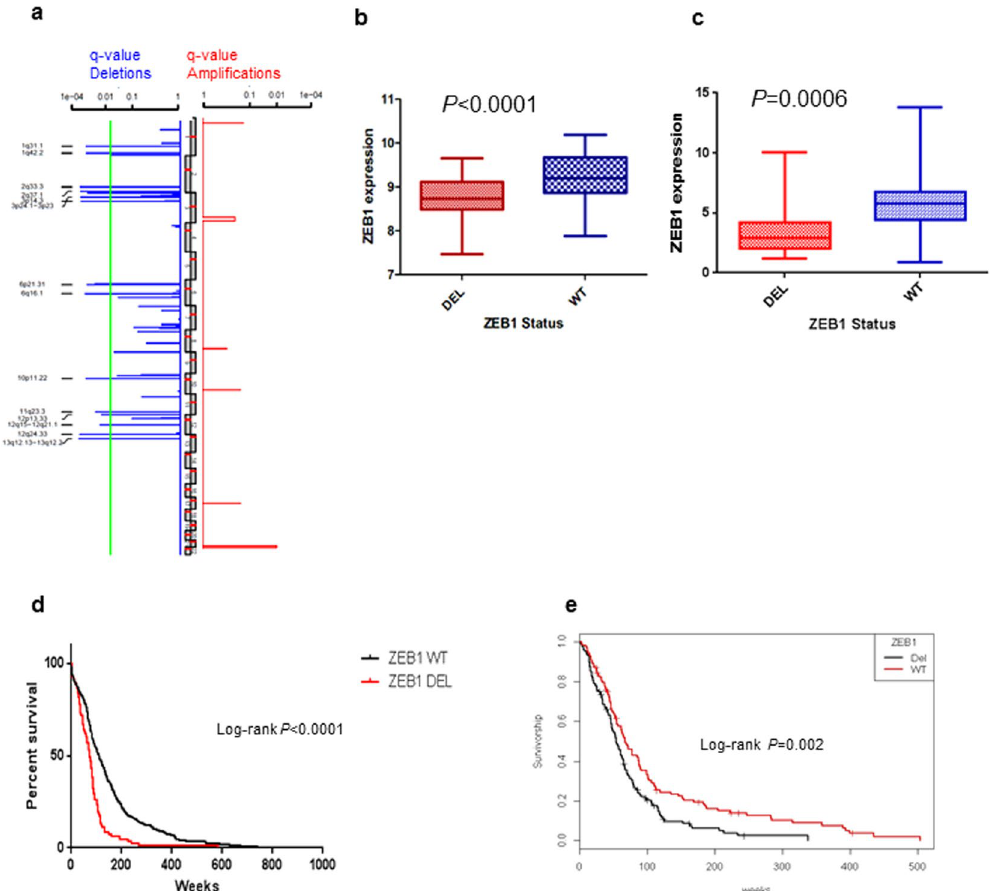
Figure 1. Somatic Copy Number Alterations. ( a ) Copy number alterations determined for 70 low grade gliomas (grade II and III) by single nucleotide polymorphism (SNP) arrays. Significant amplifications (red) and deletions (blue) were determined for the chromosomal regions and are plotted as q-values (significance < 0.05). ( b ) ZEB1 deletion (DEL) for glioblastomas, defined as copy number less than or equal to − 0.5 ( n = 188); wildtype (WT) defined as copy number greater than or equal to zero ( n = 62). Two-tailed student’s t-test identified a significant difference between these two groups *** P < 0.0001. ( c ) ZEB1 deletion (DEL) for low grade gliomas ( n = 79); wildtype (WT) ( n = 372), copy number was previously called for DEL or WT in cBioportal. Two-tailed student’s t-test identified a significant difference between these two groups ** P = 0.0006. ( d ) Estimated Kaplan-Meier survival curves for 451 low grade glioma patients (left) for deleted (DEL) and wildtype (WT) copy number. Patients with low grade gliomas having DEL vs. WT ZEB1 had estimated median survival times of 16.82 vs. 25.46 months. P -value was determined by log rank test *** P < 0.0001, hazard